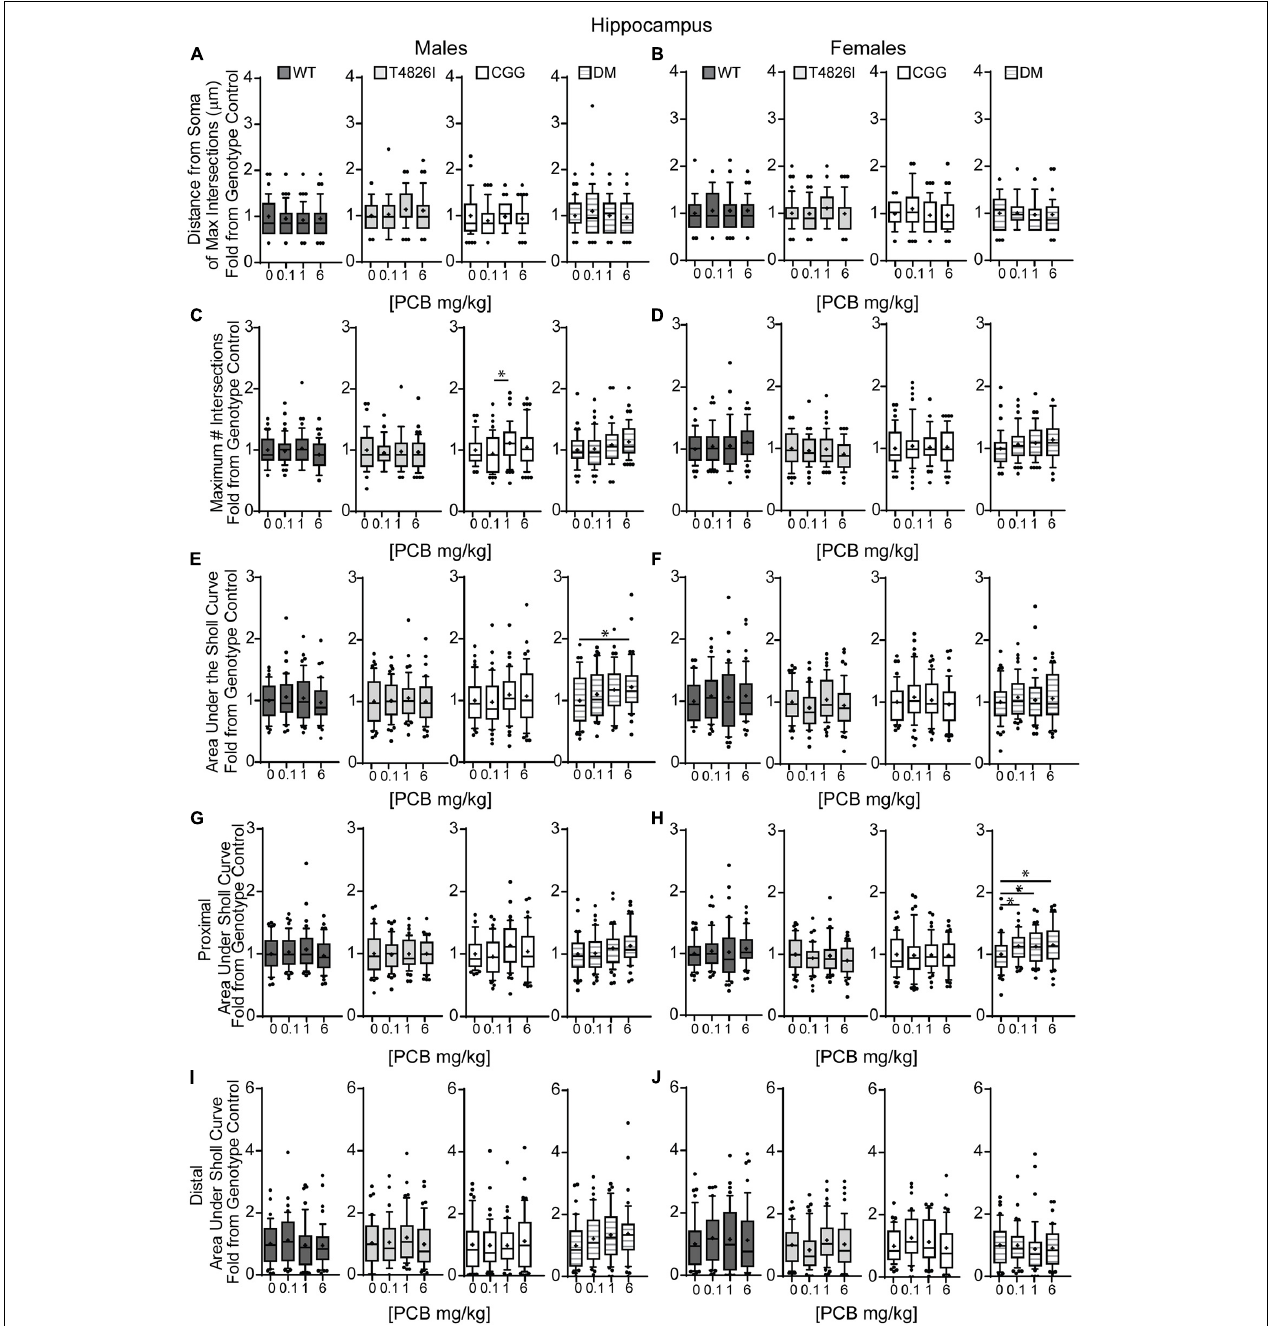
FIGURE 2 | Double mutant mice are more sensitive to effects of PCBs on the dendritic morphology of pyramidal neurons in the CA1 hippocampus of juvenile mice. Morphometric analyses of the basilar dendritic arbors of Golgi-stained pyramidal CA1 hippocampal neurons from P27–31 male and female WT, T4826I, CGG, or DM mice exposed to the MARBLES PCB mixture in the maternal diet throughout gestation and lactation. (A,B) The distance from the soma to the maximum number of dendritic intersections (Peak X). (C,D) The maximum number of dendritic intersections (Peak Y). (E,F) The total area under the curve of the Sholl plot (0–240 µ m from the soma). (G,H) Proximal area under the curve of the Sholl plot (10–70 µ m from the soma), and (I,J) distal area under the curve of the Sholl plot (80–140 µ m from the soma). Data ( N = 39–49 neurons from at least six independent mice per sex per genotype per dose) are presented as box plots, where the box indicates the lower (25th) to upper (75th) quartiles, the “+” indicates the mean, whiskers indicate the 10–90th percentile, and dots represent values outside the upper or lower fences. *Significantly different from control at p ≤ 0.05 as determined by Kruskal–Wallis test followed by Dunn’s multiple comparisons test. Average values of vehicle controls for WT, T4826I, CGG and DM, respectively, are (A) 46.9, 40.8, 47.9, 47.3 µ m; (B) 42.3, 44.9, 48.5, 46.4 µ m; (C) 11.9, 10.8, 10.8, 10.4 intersections; (D) 10.8, 11.3, 11.2, 10.1 intersections; (E) 773.8, 698.2, 727.7, 713.8 µ m 2 ; (F) 721.1, 787.2, 807.8, 715.1 µ m 2 ; (G) 493.7, 454.1, 456.9, 450.5 µ m 2 ; (H) 466.7, 497.2, 492.1, 420.3 µ m 2 ; (I) 192.2, 164.6, 188.6, 178.8 µ m 2 ; and (J) 170.8, 197.4, 216.5, 202.6 µ m 2